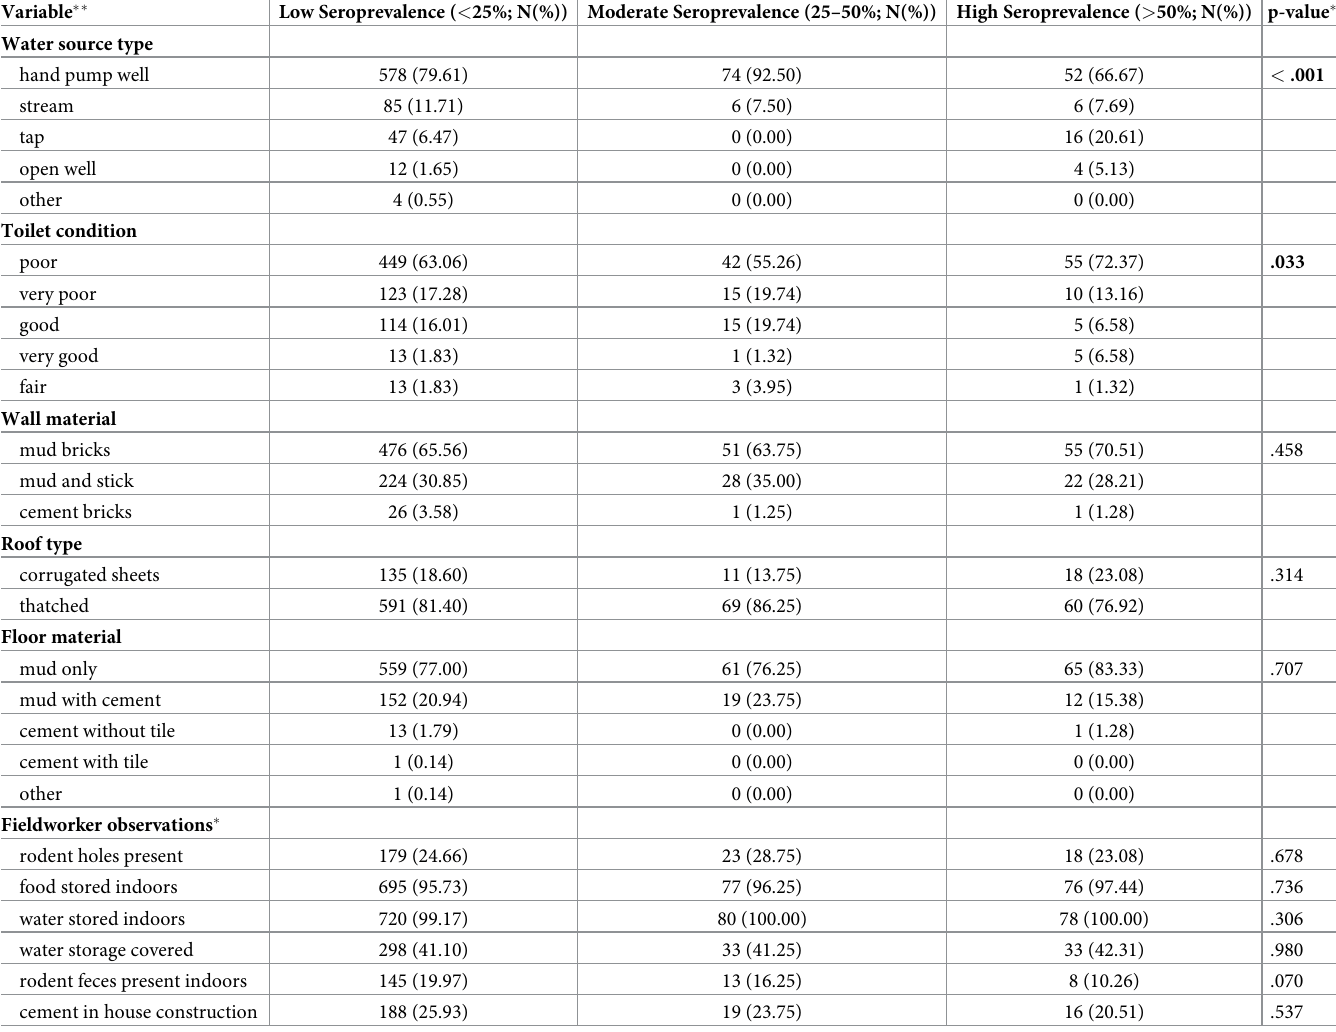
Table 3. Percentage of households’ construction materials and fieldworker observations, comparing household level LASV IgG seroprevalence (n = 903). The likeli- hood of a household having greater than 50% seroprevalence was determined in a multivariate analysis. The analysis between these three groups determine potential corre- lates of exposure to